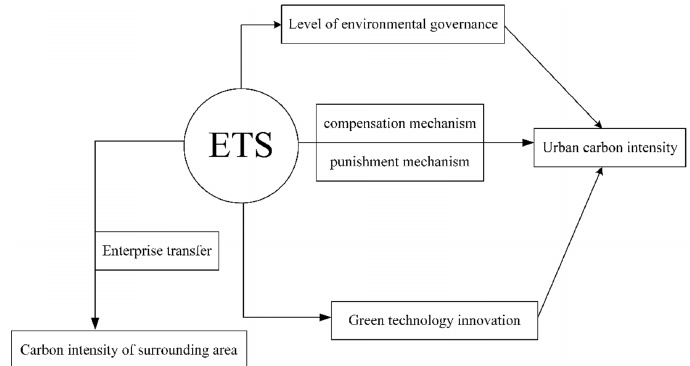
Figure 1. Theoretical background of the study.